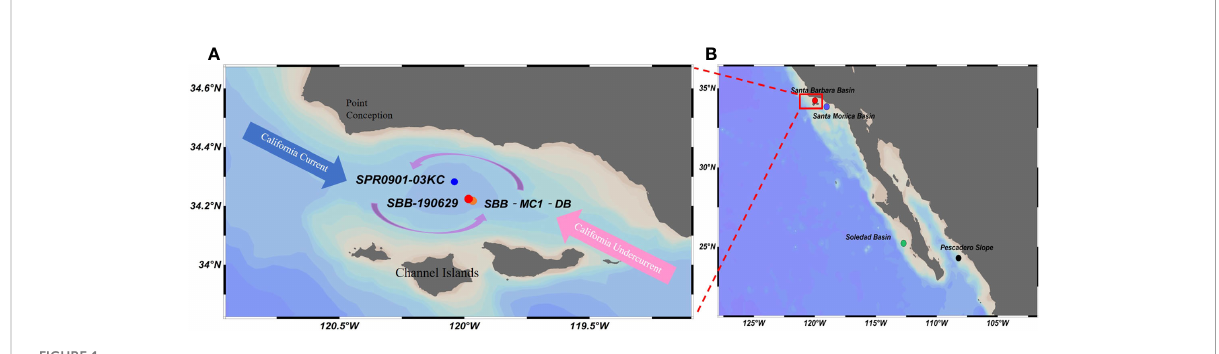
FIGURE 1 (A) Map of Santa Barbara Basin and the surrounding region, showing sampled and referred core locations in Santa Barbara Basin (SBB). Red circle ( ● ), core SBB-190629 (this study); blue circle ( ● ), core SPR0901 ‐ 03KC from Wang et al. (2019); orange circle ( ● ), core SBB-MC1-DB from Davis et al. (2019). Major currents are mentioned in the text. (B) Locations of core sites along the North American margin are referred to in this study. Red circle ( ● ), Santa Barbara Basin core location in this study. Purple circle ( ● ), Santa Monica Basin core location from Davis et al. (2019). Green circle ( ● ), Soledad Basin core location from Deutsch et al. (2014). Black circle, Pescadero Slope core location from Deutsch et al. (2014). Red box indicates SBB region and is enlarged in panel